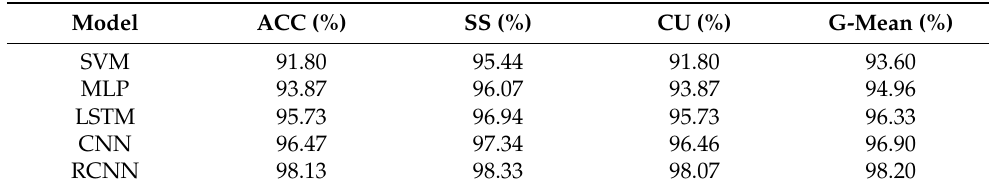
perceptron), whose hidden layer size is 390 neurons; (3) LSTM with a setting of 128 neurons as its memory unit; and (4) CNN with 3 hidden layers composed of 64, 32, and 4 filters and common size of 3 × 3. Table 6. Metrics comparison among different